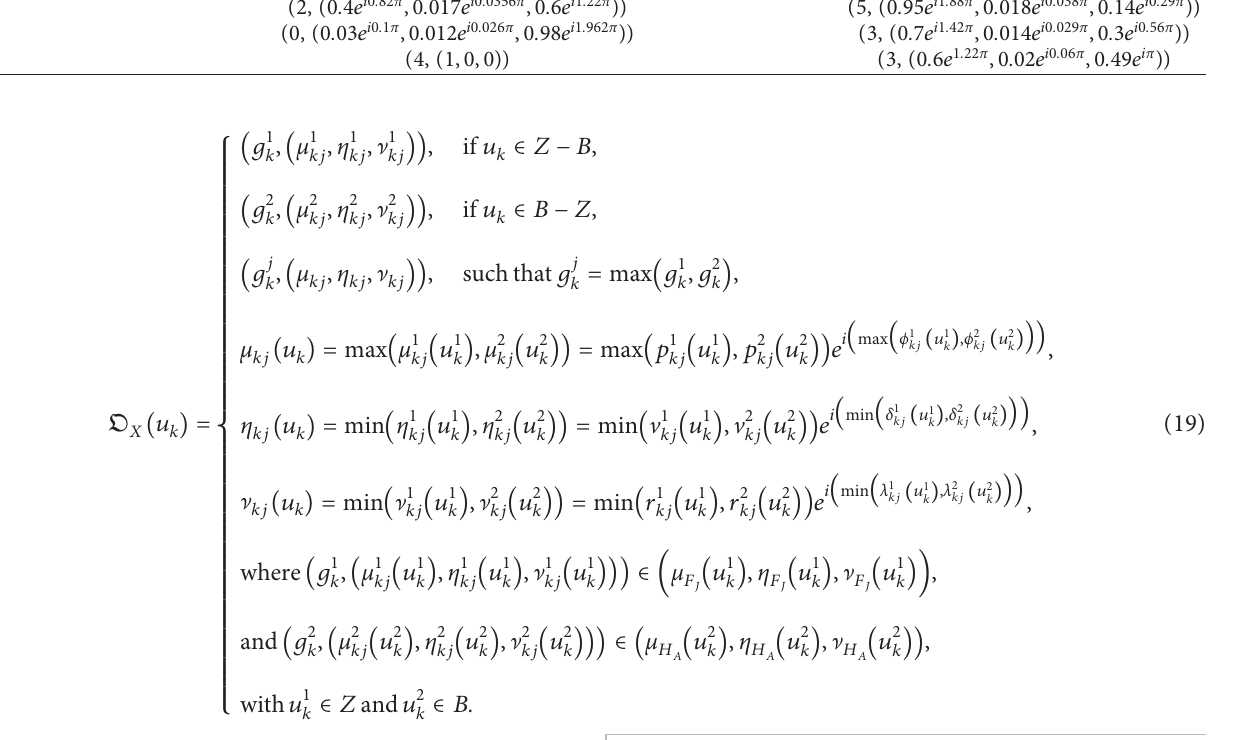
Table 14: Tabular representation of restricted union ( R